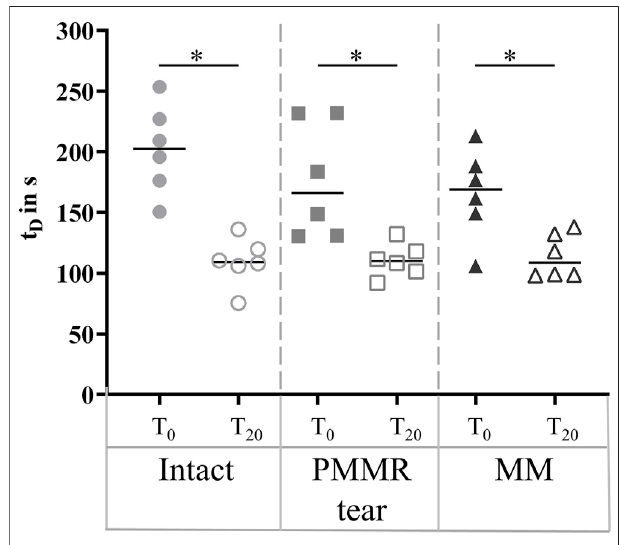
FIGURE 8 | Scatter plots (median with individual values) of the damping time (t D ) in seconds of the pendulum motion under stance phase conditions with the intact meniscus state (symbol shape: circles), with a posterior medial meniscus root tear (PMMR tear) (symbol shape: squares) and after medial meniscectomy (MM) (symbol shape: rectangles). The tests were performed directly after loading the joints with 1000 N (T 0 , fi lled symbols) and after resting under the axial load for 20 min (T 20 , un fi lled symbols). Non- parametric statistical analyses: n (cid:1) 6; * p <